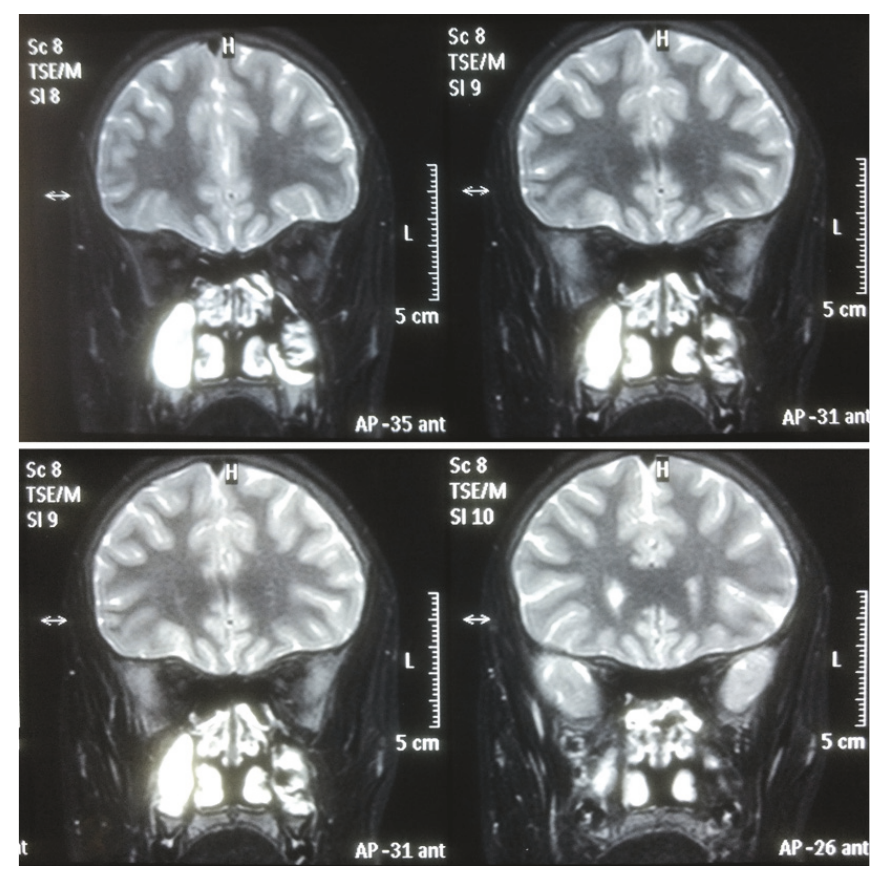
Figure 2: MRI head and orbit coronal section at the level of the midorbit and apex showing absence of any granulomatous lesions nor any extraocular muscle thickening (ruling out myositis or orbital pseudotumor).